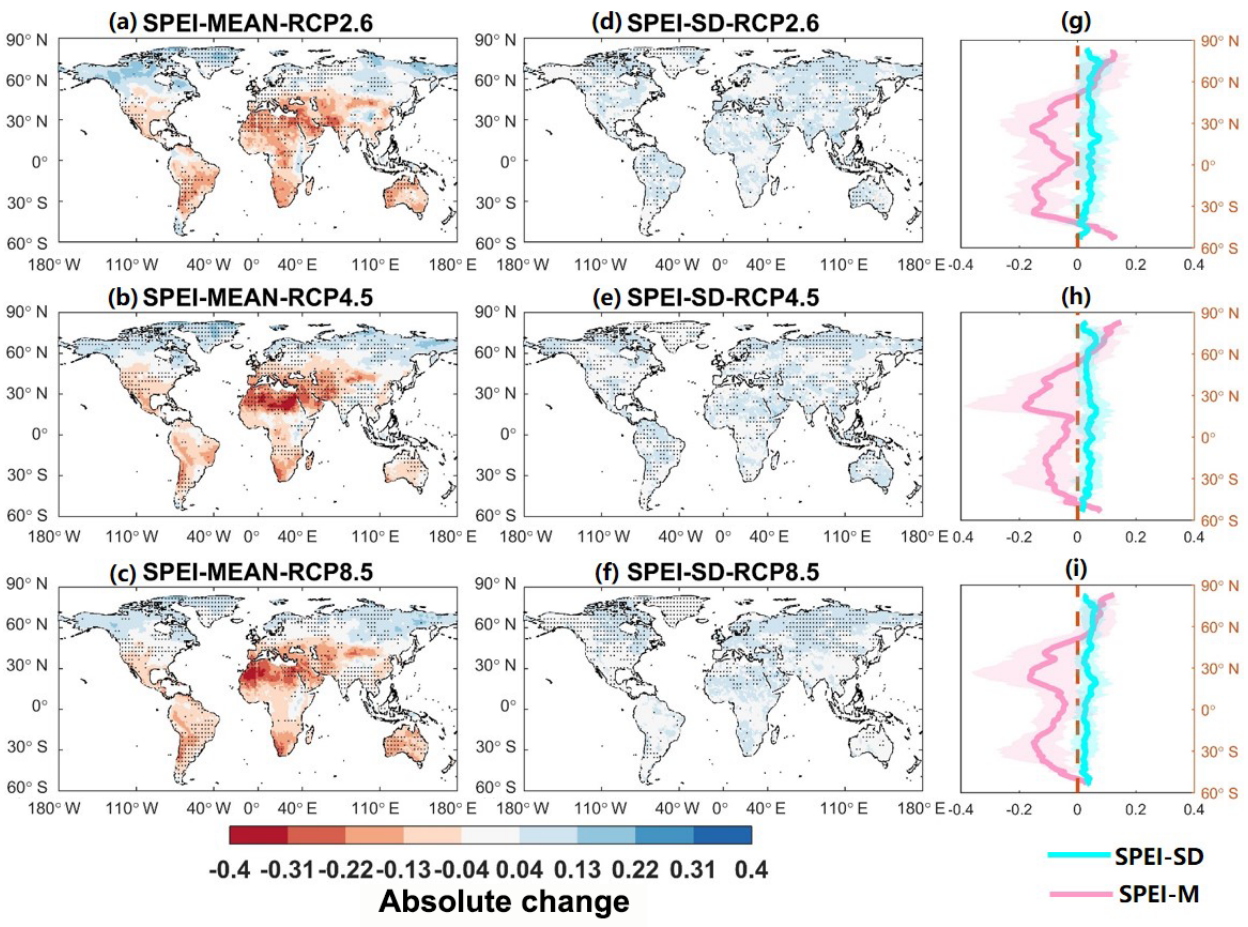
Figure 3. Projected changes in the mean and standard deviation of the SPEI between the 1.5 and 2.0 ◦ C warming